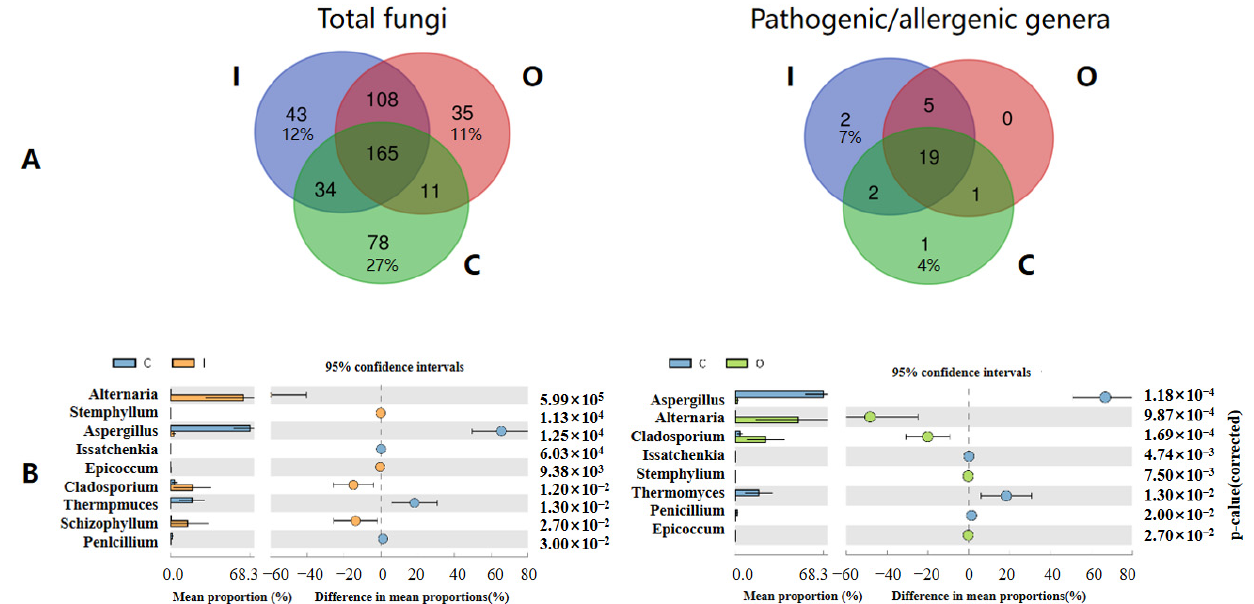
Figure 4. Common and endemic fungi in air and compost piles. ( A ) Number of common and endemic total fungi and pathogenic/allergenic genera in composting piles (C), inside (I), and outside air (O) of composting workshop using a Venn diagram, ( B ) Identification of different pathogenic/allergenic genera between C and I, or C and O using Stamp analysis. The bar chart shows the average proportion of differential pathogenic/allergenic genera predicted using Picrust 2. The difference in proportions between any two groups is presented with 95% confidence intervals. Only p < 0.05 (Welch’s t test, FDR adjusted) are depicted.